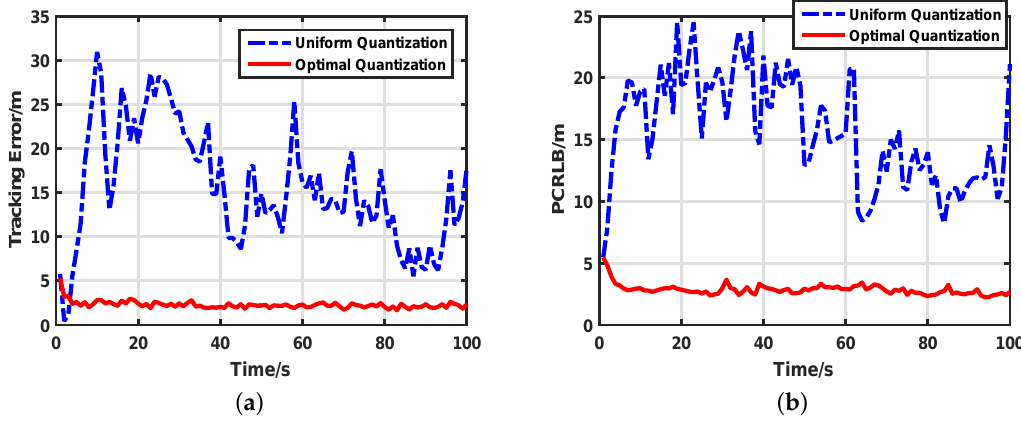
Figure 4. Detailed tracking performance with 1-bit quantized measurements of two schemes. ( a ) Target tracking error; ( b ) posterior Cramer–Rao lower bound